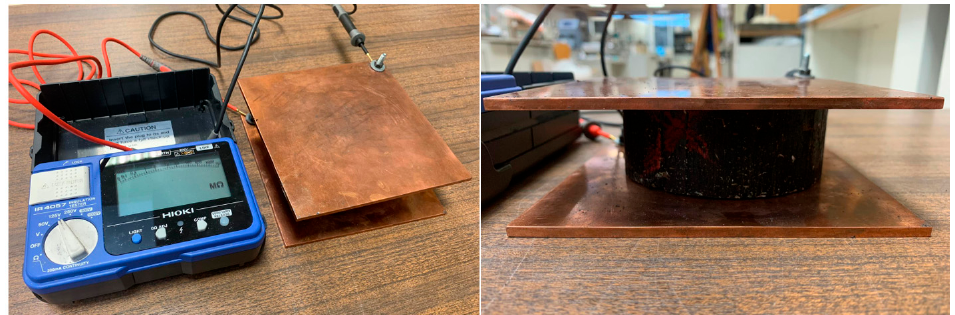
Figure 5. Electrical resistivity measurement.